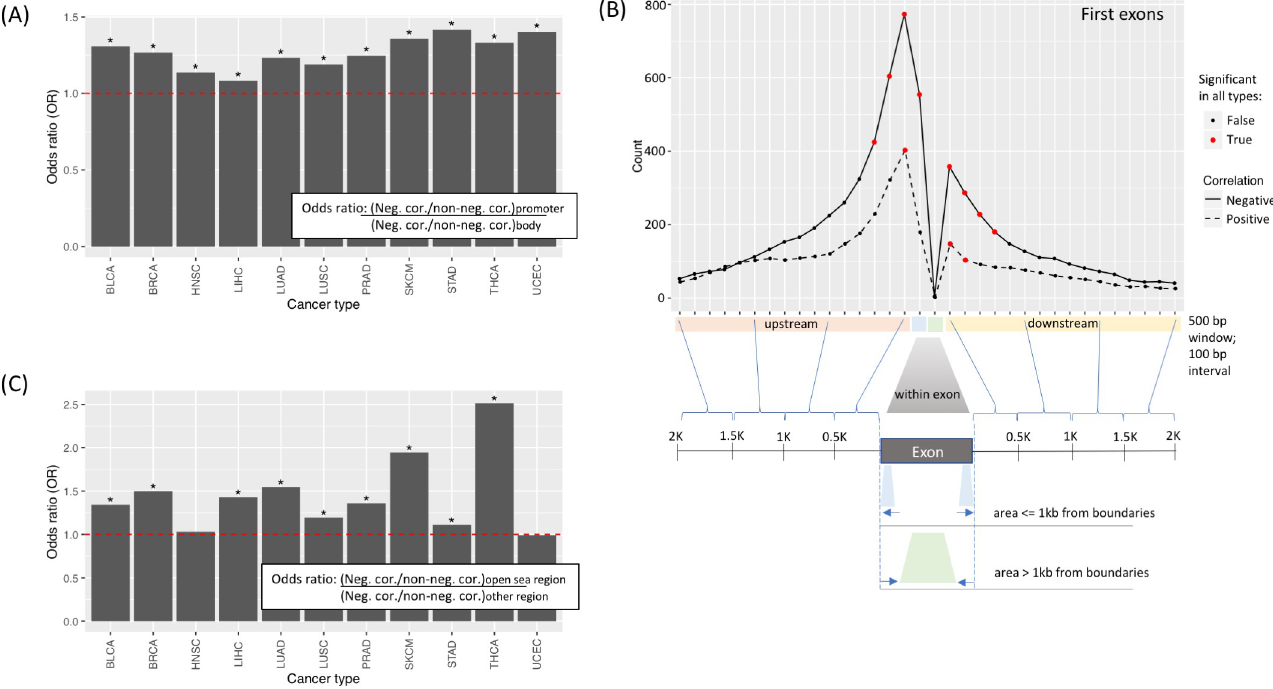
Fig 1. Negative correlations between isoform usage and DNAm show enrichment in promoter regions relative to isoform bodies. (A) The odds ratios were computed between the ratio of negative versus positive correlations in isoform promoters and isoform bodies for each cancer type. (B) The median count (among 11 cancer types) of positive and negative correlations computed in binned regions of 500 bp. Regions include upstream, within, and downstream of first exons. Each dot represents a sliding window of 500bp with a sliding interval of 100bp. Significant or nonsignificant windows in 11 cancer types are indicated by red and black dots. Negative and positive correlations are shown with solid and dashed lines. Distances within exons of < = 1kb or > 1kb from exon boundaries are illustrated. (C) Negative correlations within 1kb around the first exon boundaries were enriched in open sea regions compared to CGIs or shores and shelves (OR >